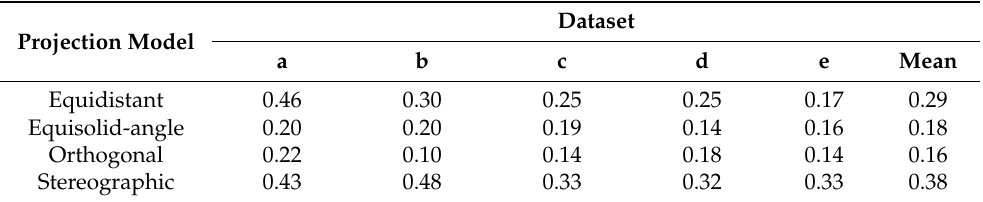
Table 9. Root Mean Square residuals (RMS-residuals) of Interior Orientation Parameters (IOPs) (pixel) in simulation experiments.